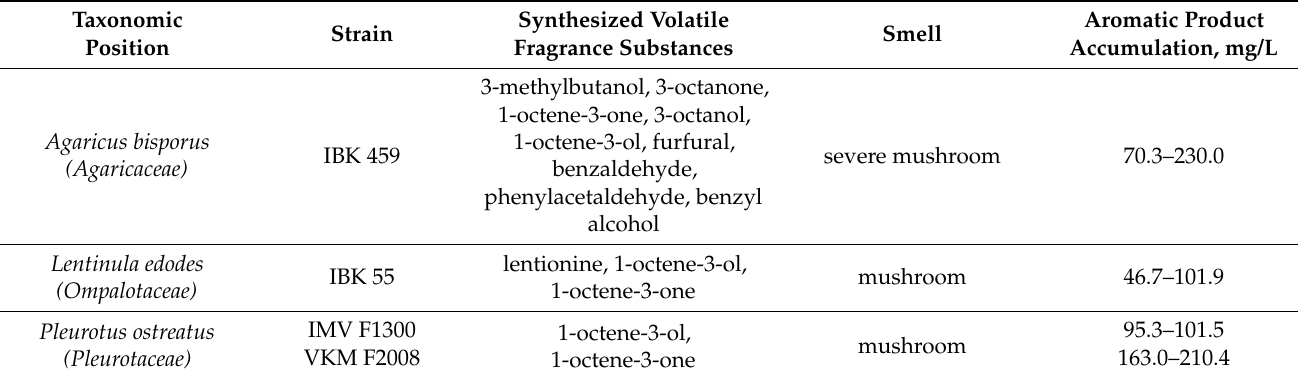
Table 1. Flavor evaluation results of the basidiomycete species studied.